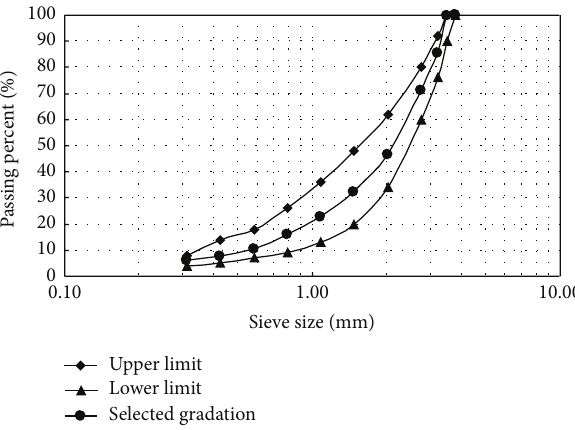
Figure 1: Aggregates gradation curves for asphalt mixture.